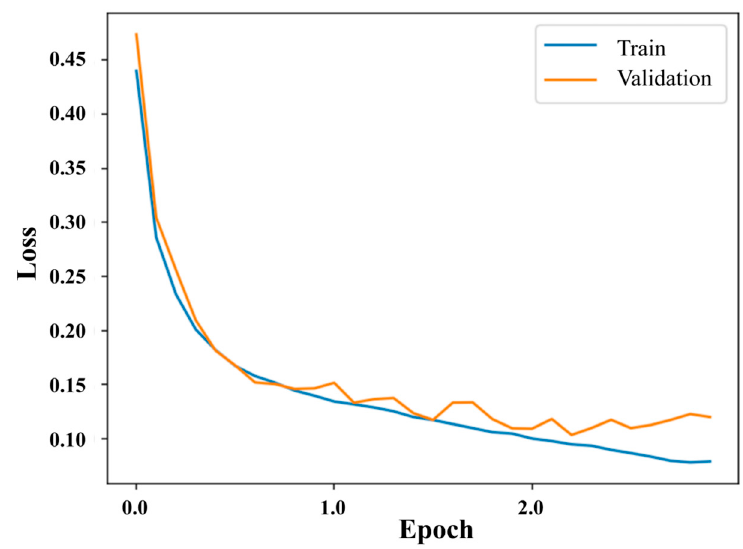
Figure 10. Loss curve of the training work.